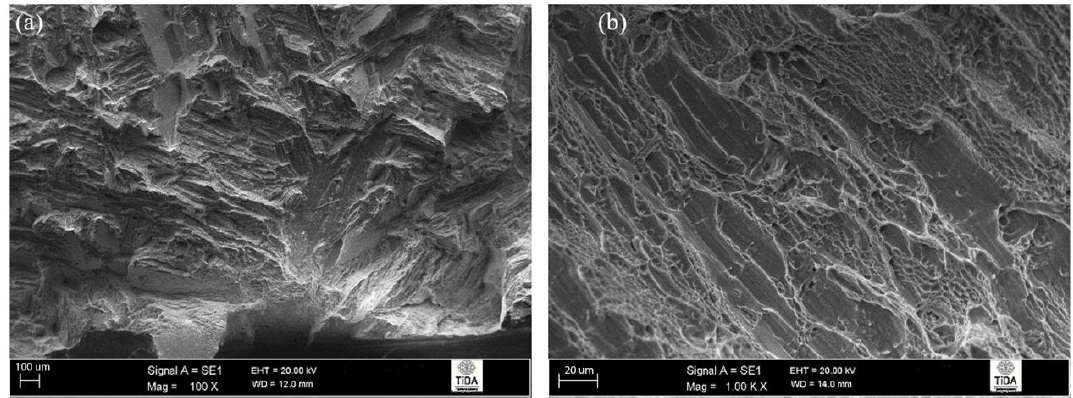
Figure 9. Fracture surface of 1200 °C/30 min, FC, 730 °C/2 h heat-treated Ti-6Al-4V alloy: ( a ) cleavage fracture; ( b ) ductile dimples.